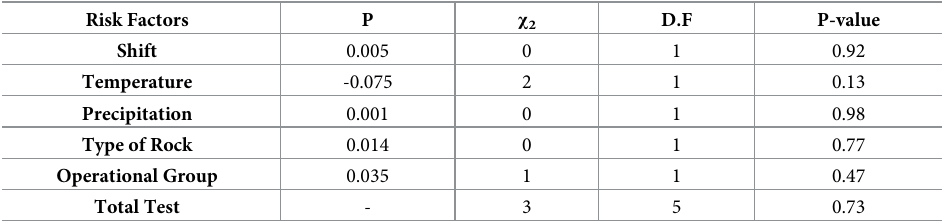
Table 3. The P-value values for the estimation of the PH of risk factors.